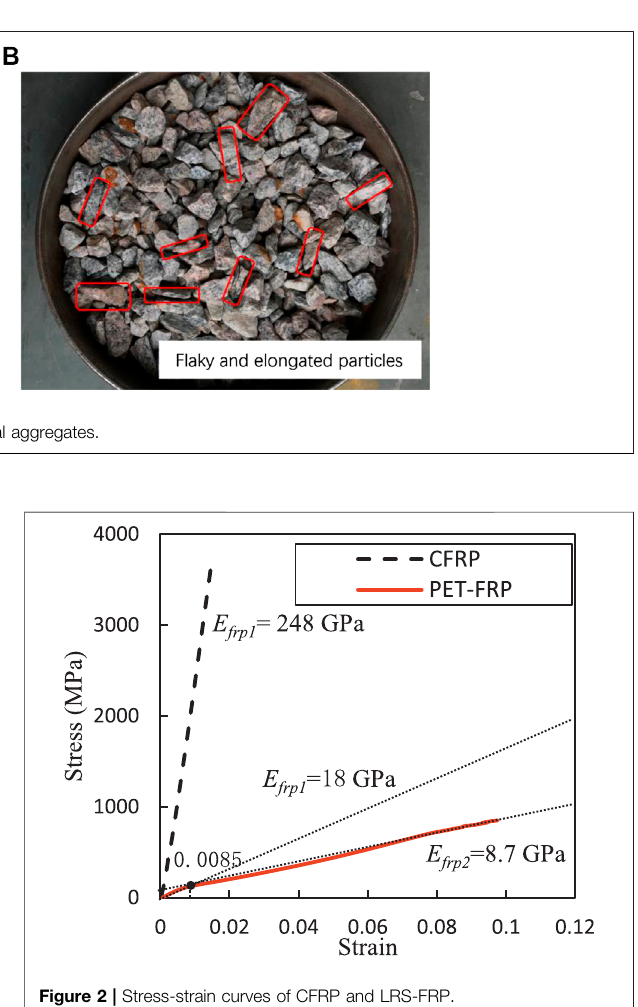
Figure 2 | Stress-strain curves of CFRP and